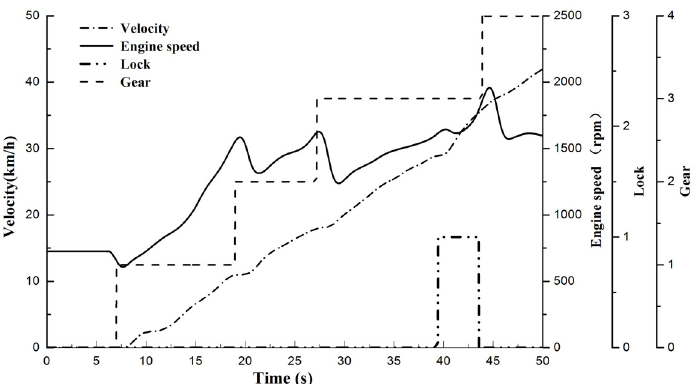
Figure 9. Real vehicle experimental data.